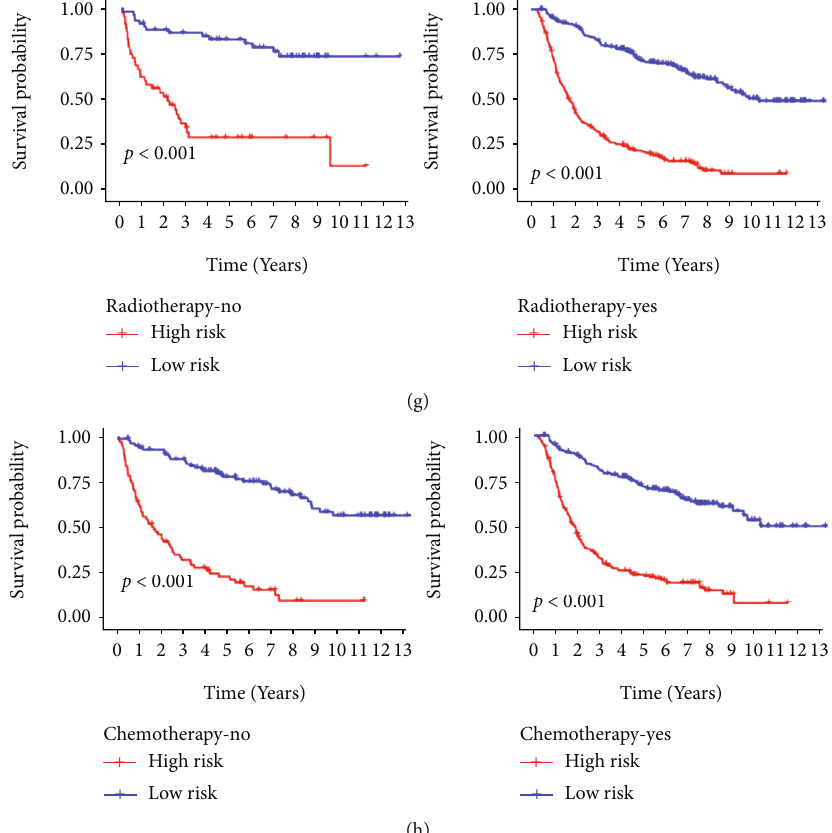
Figure 5: Kaplan – Meier survival curves strati fi ed by di ff erent clinical features in the CGGA cohort. Survival analyses using the IRRG signature in patients with di ff erent (a) age, (b) gender, (c) grade, (d) IDH, (e) 1p19q status, (f) MGMT methylation, (g) radiotherapy, (h) and